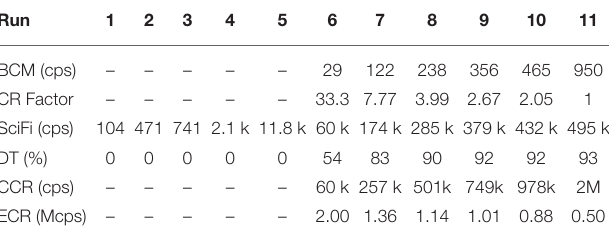
TABLE 2 | Measured count rate (CR) in the plastic scintillator bunch monitor (BCM) and in the scintillating fibers